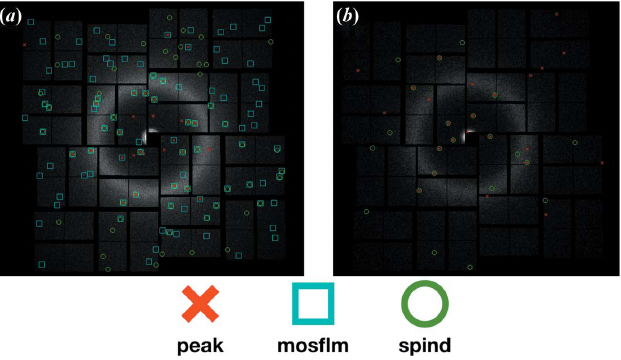
Figure 8 Representative indexed diffraction patterns from the ClR data set, recorded on the CSPAD. ( a ) indexable by both MOSFLM and SPIND , ( b ) indexable only by SPIND . Identified peaks are marked by red crosses, and peak positions predicted from the orientation matrix given by MOSFLM and SPIND are marked with cyan and green circles, respectively. The overlapping cyan and green circles in ( a ) correspond to the same Miller indices, thus confirming the consistency of the indexing results between SPIND and MOSFLM